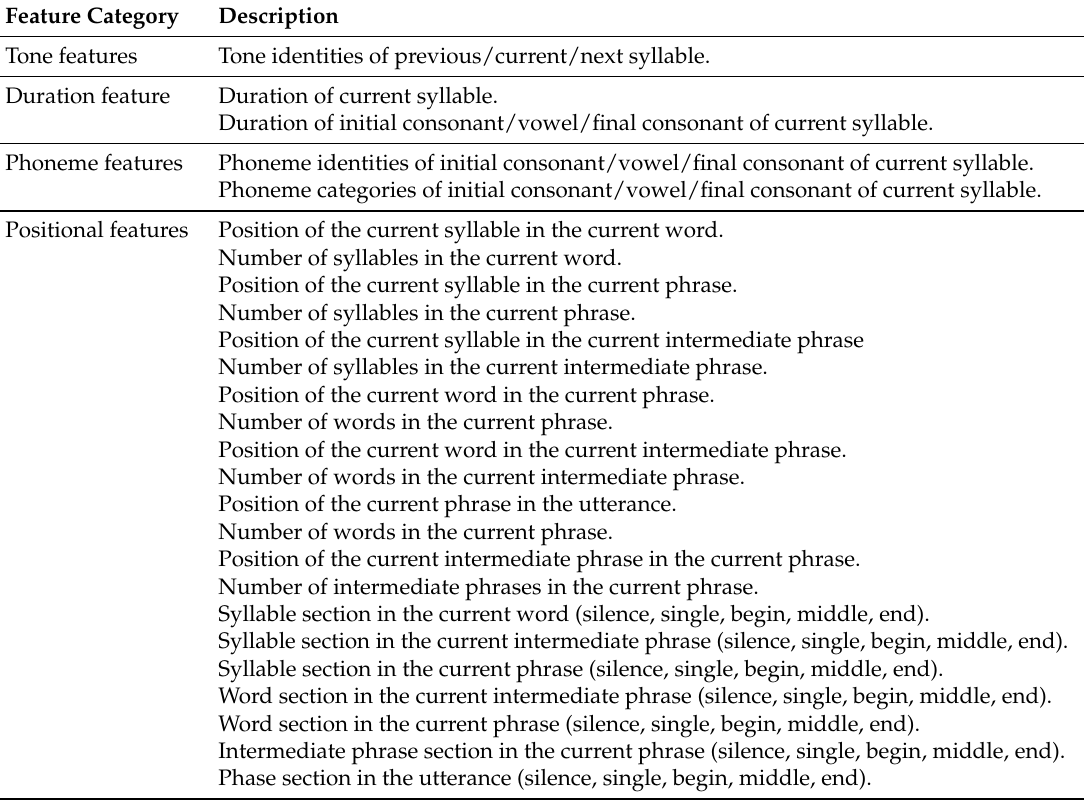
Table 1. Linguistic features for training the proposed